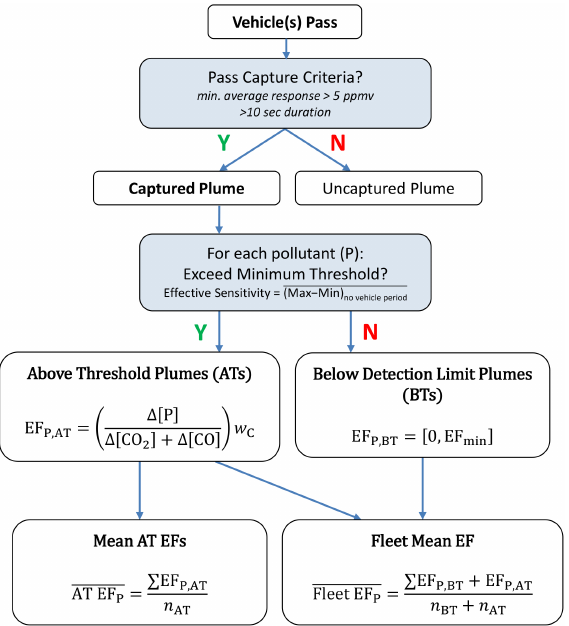
Figure 3. Process flow diagram of plume identification and capture criteria for AT and BT EFs, and the calculation for mean AT and mean fleet